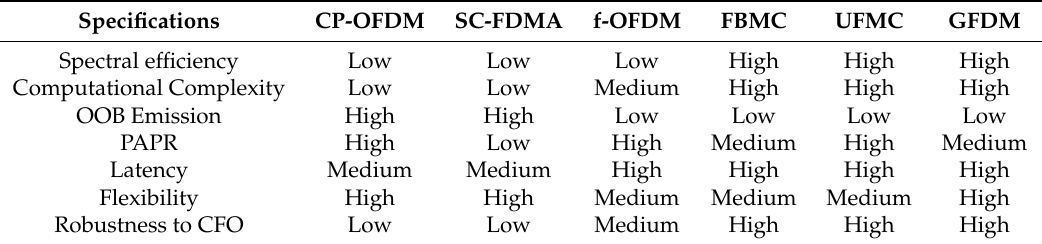
Table 2. Comparison of waveform candidates of the emerging xG Networks.